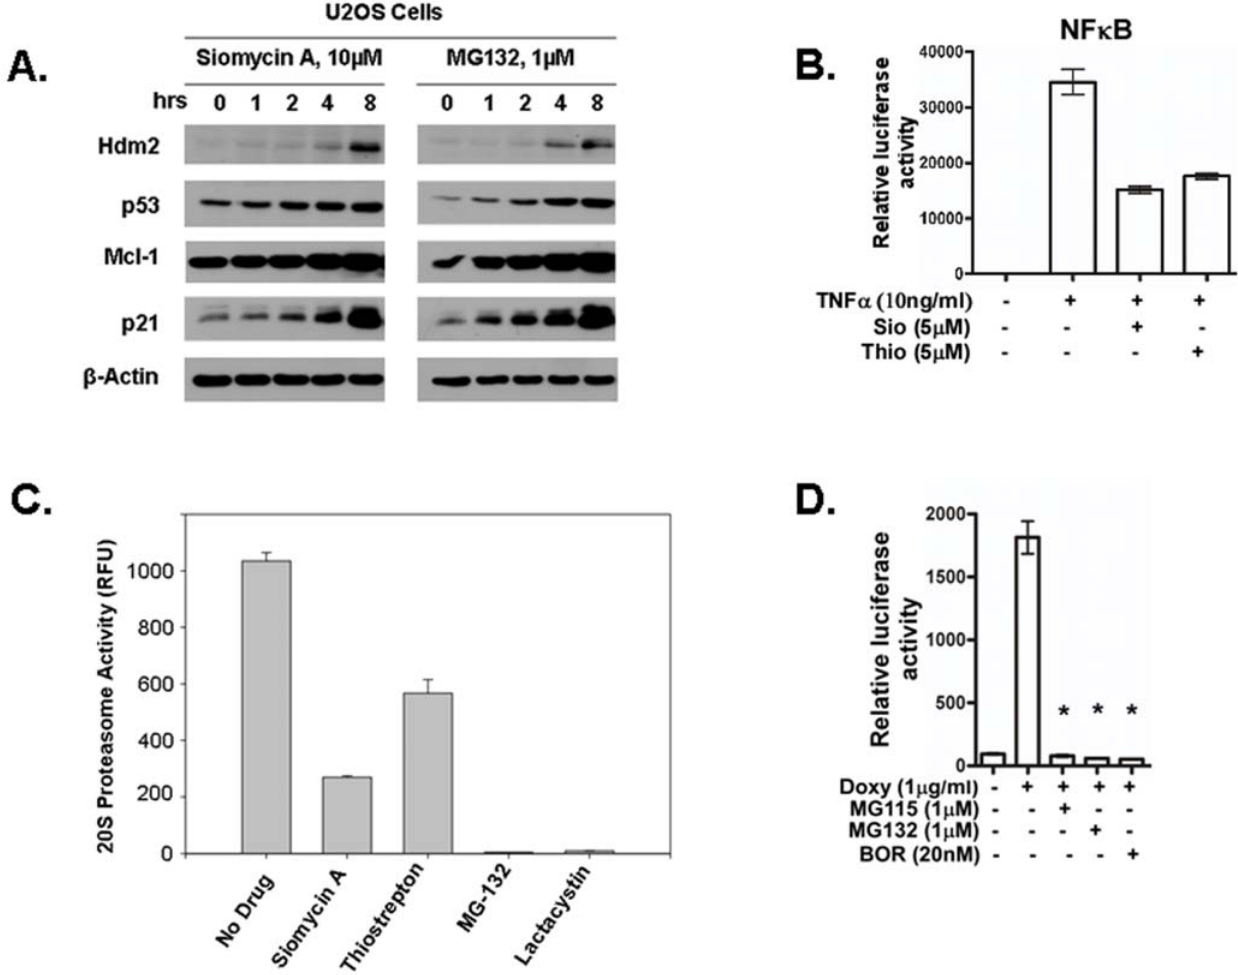
Figure 1. Thiazole antibiotics act as proteasome inhibitors and the known proteasome inhibitors target FoxM1. (A) Siomycin A stabilizes protein expression similarly to proteasome inhibitor MG132. U2OS cells treated as indicated were harvested and immunoblotting was carried out with antibodies specific for p53, p21, hdm2, Mcl-1, and b -actin. (B) Thiazole antibiotics inhibit NF-kB transcriptional activity. 293T-NF- k B-Luc cells were induced with 10 ng/mL TNF- a for 24 hrs and treated with 5 m M of the thiazole antibiotics for additional 10 hrs followed by luciferase assay. The results shown are mean 6 SD of three separate experiments. (C) Inhibition of 20S proteasome activity by Siomycin A and thiostrepton. The inhibition of proteasome activity by the thiazole antibiotics in vitro was less efficient compared with proteasome inhibitors, MG- 132 and lactacystin as detected by using 20S Proteasome activity kit (Millipore). The free AMC fluorescence was quantified at 380/460 nM in a fluorometer (SpectraMax GeminiXS, Molecular Devices). The results shown are mean 6 SD of three separate experiments. (D) Proteasome inhibitors inhibit FoxM1 transcriptional activity. C3-Luc cells were treated with a combination of 1 ug/ml doxycycline and the indicated concentrations of the proteasome inhibitors MG115, MG132 and bortezomib (BOR). The luciferase activity was determined by using the Luciferase Assay System (Promega) according to the manufacturer’s instructions. The results shown are mean 6 SD of three independent experiments. The asterisks on each graph represent statistically significant differences with p values , 0.001.